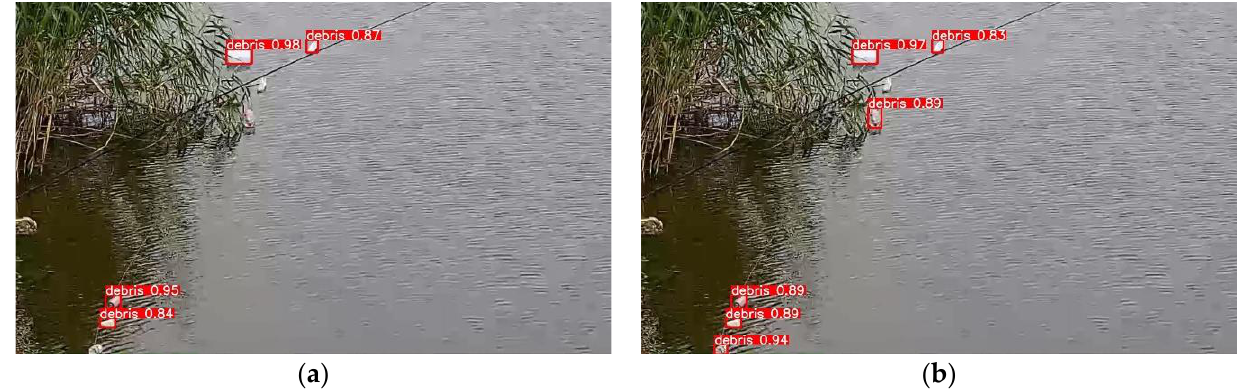
Figure 4. Comparison of detection effects. ( a ) The detection effect of YOLOv5, ( b ) the detection effect of YOLOv5 introducing the CA module.